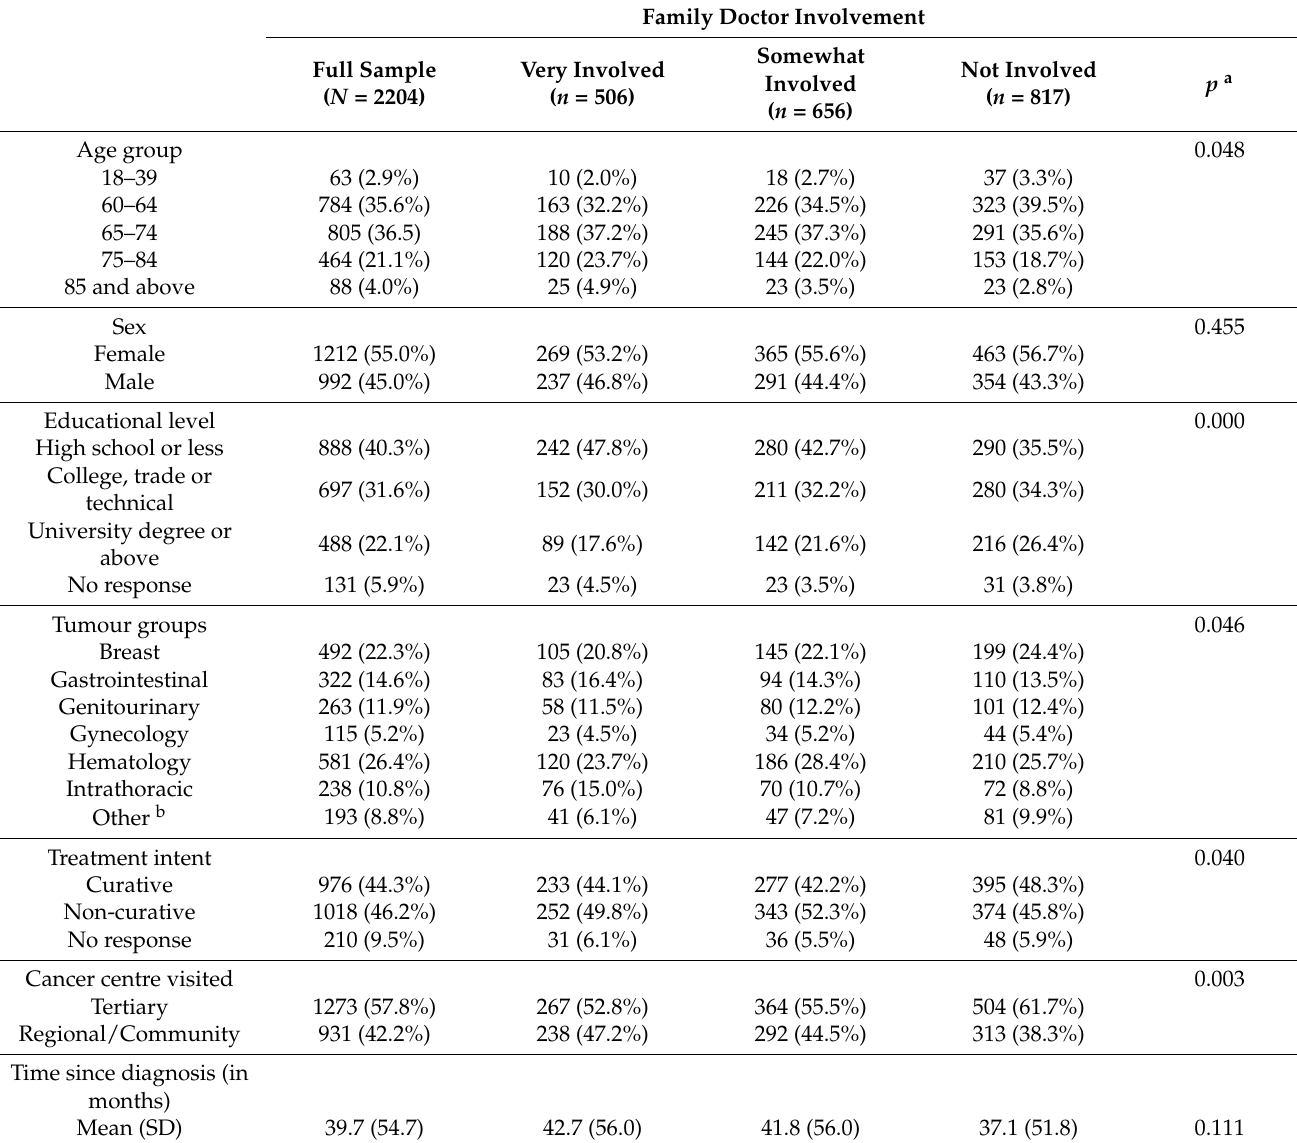
Table 1. Distribution of sociodemographic and disease-specific variables by family doctor involvement. Family Doctor